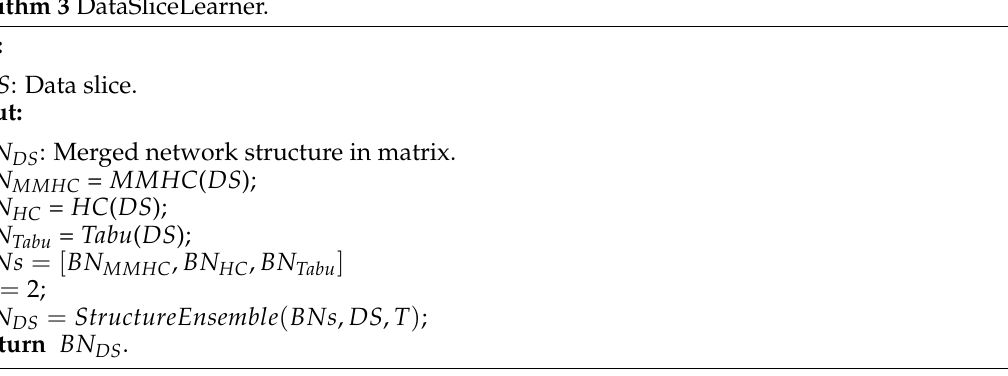
Algorithm 3 DataSliceLearner.